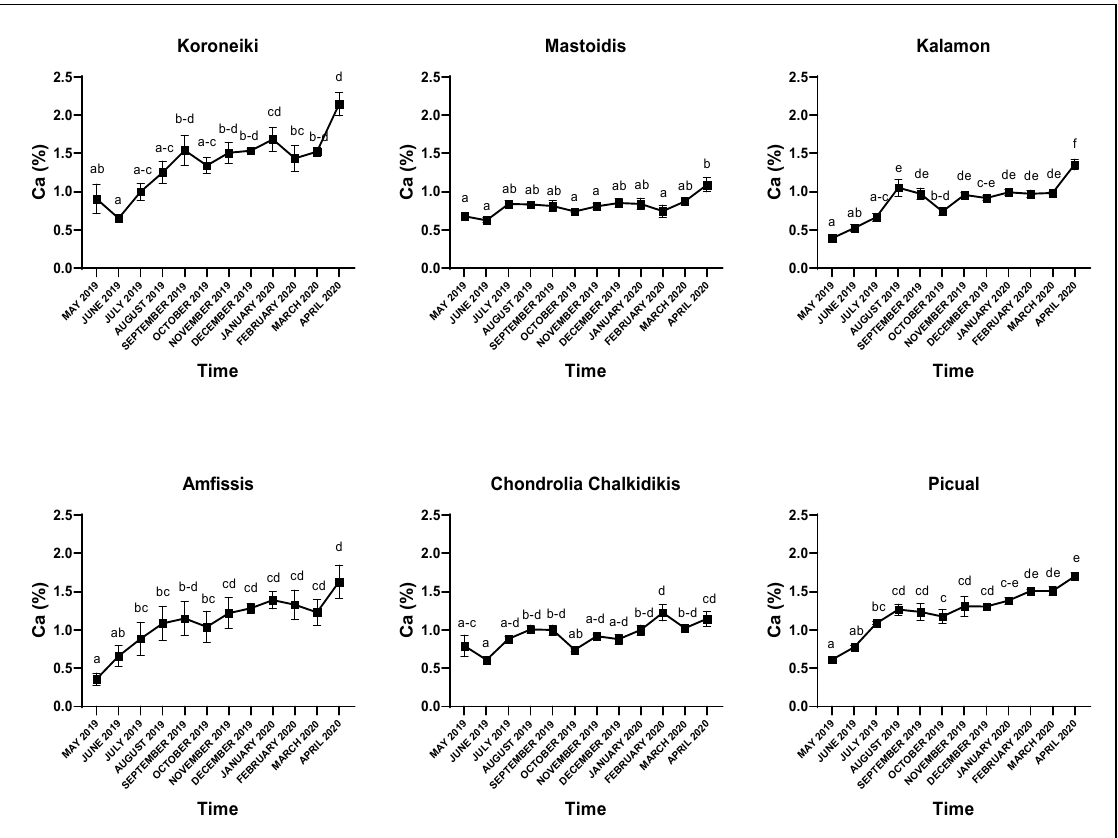
Figure 3. Seasonal trends of calcium concentration in olive leaves developed during annual growth. Error bars represent the standard error of the mean of three replicates. Means within a variety followed by the same letters do not differ at p < 0.05 (LSD test).